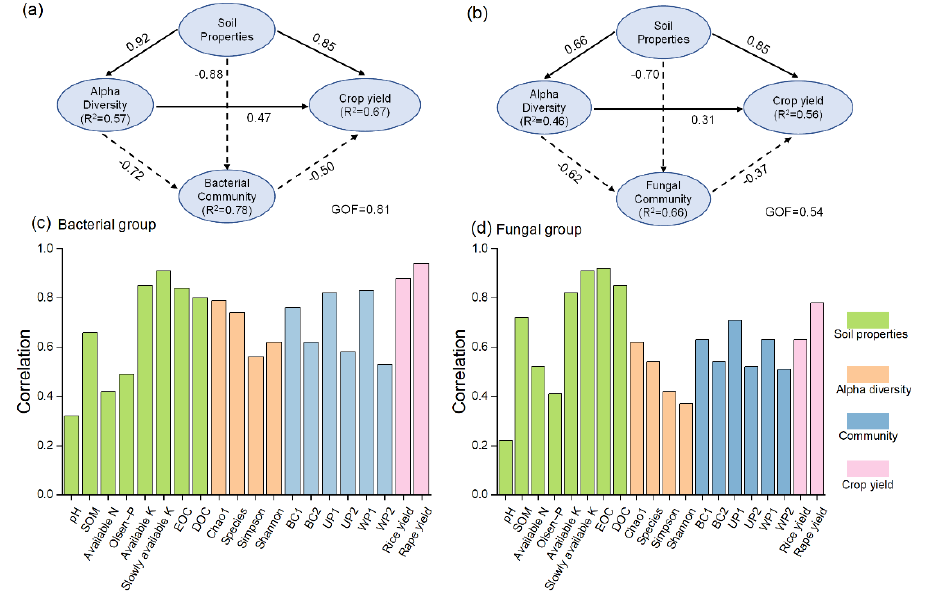
Figure 7. Partial least squares path models (PLS_PM) for the rice and oilseed rape yield in 2020. A line with an arrow indicates a causal relationship, supplemented by a path coefficient, and continuous and dashed lines indicate positive and negative relationships for ( a , b ), respectively; the amount of the variability explained by the variables for ( c , d ). Path coefficients are calculated after 1000 bootstraps. BC1: Bray − Curtis PCoA1; BC2: Bray − Curtis PCoA2; UP1: Unweighted Unifrac PCoA1; UP2: Unweighted Unifrac PCoA2; WP1: Weighted Unifrac PCoA1; WP2: Weighted Unifrac PCoA2.